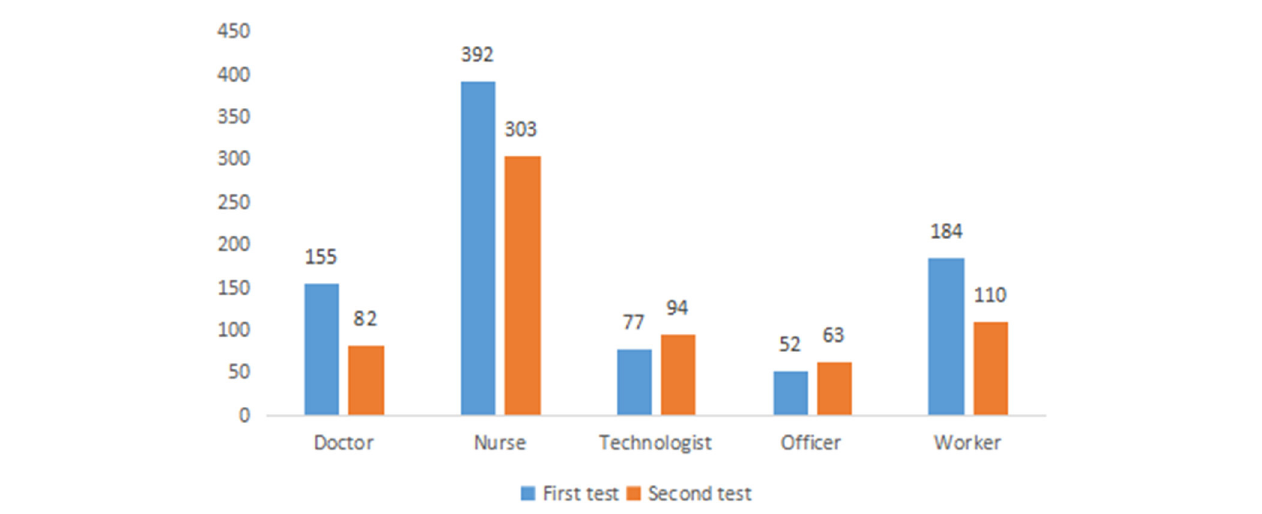
FIGURE 2 | Comparison of the number of people in different majors participating in the two assessment.